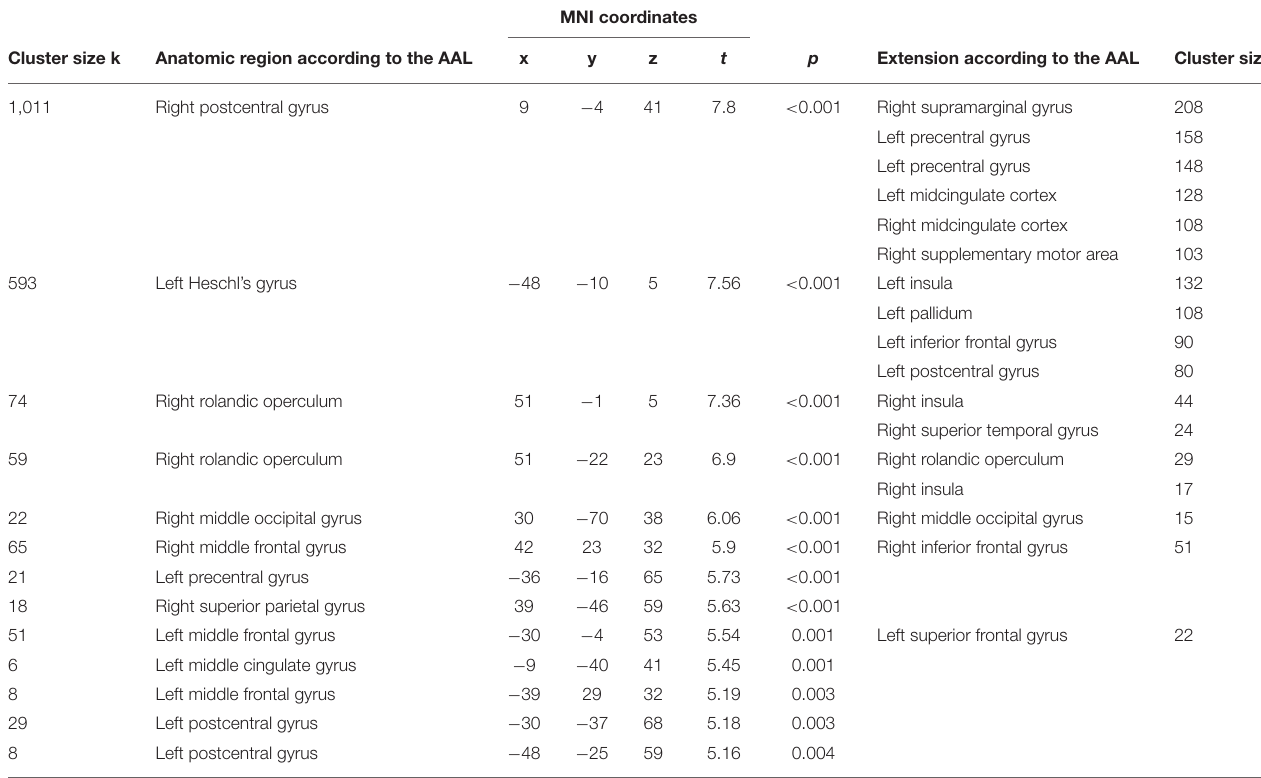
TABLE 2 | Whole brain analysis of functional hyperactivations in high functioning individuals at ultra-high risk for psychosis compared to control group during general facial emotion recognition.